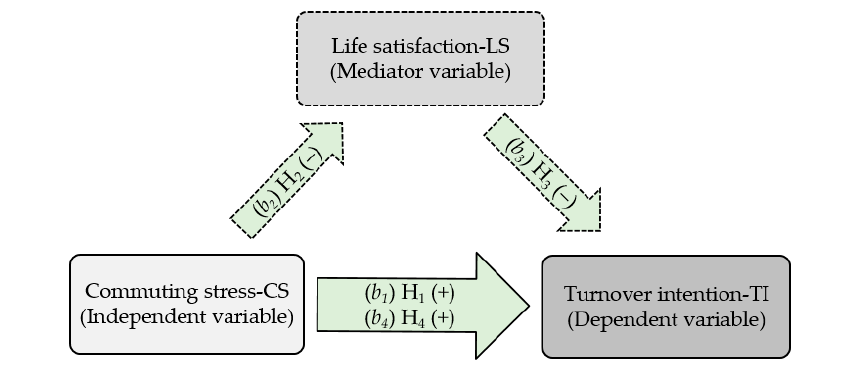
Figure 2. The hypothesized mediation model for the study.